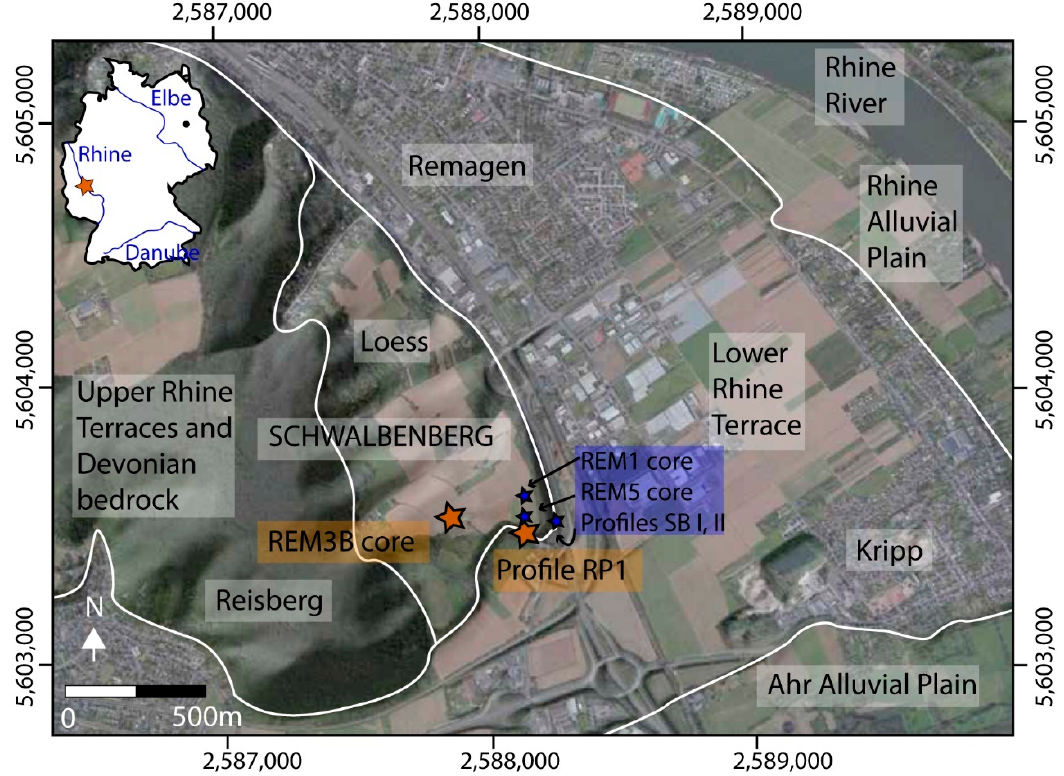
Figure 1. Map of the Schwalbenberg study area, west of the Rhine River and southwest of the city of Remagen (position within Germany shown in inset). The locations of the REM3B core and profile RP1 which form the focus of this study are indicated by orange stars. Blue stars denote previously studied sections and cores (SB I, SB II, REM1, REM5). Prominent breaks in slope are highlighted in white. The map is based on data from the digital elevation model (DGM 5), Geo- basisdaten, Landesvermessungsamt Rheinland-Pfalz and Microsoft Bing